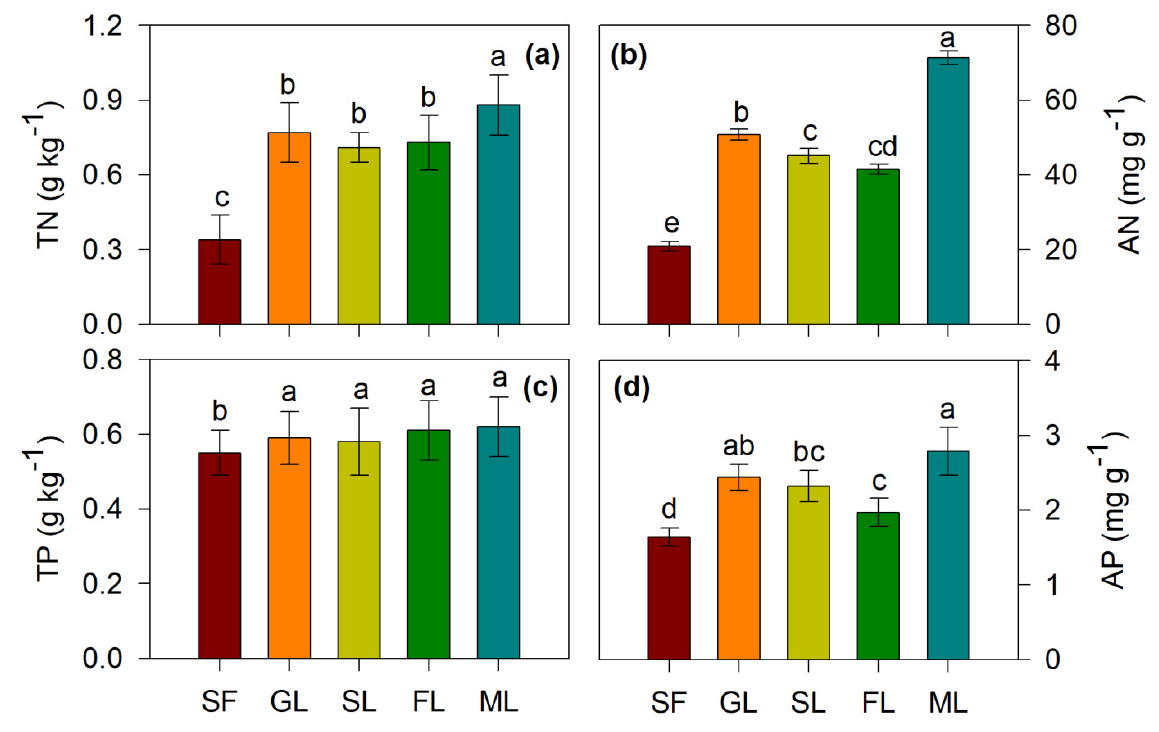
Figure 3. Soil N and P nutrients in different vegetation restoration types. TN ( a ), total nitrogen; AN ( b ), available nitrogen; TP ( c ), total phosphorus; AP ( d ), available phosphorus. Note: SF, Sloping farmland; GL, Grassland; SL, shrubland of Caragana korshinskii ; FL, forestlands of Robinia pseudoacacia ; ML, mixed forests of Robinia pseudoacacia + Caragana korshinski . Different lower-case letters above the error bars indicate significant differences in different land use types at 0.05 level ( p < 0.05). Data are Means ± SE. n = 3. Table 2. Soil enzymes activities in different vegetation restoration types. Note: SF, Sloping farmland; GL, Grassland; SL, shrubland of Caragana korshinskii ; FL, forestlands of Robinia pseudoacacia ;; ML, mixed forests of Robinia pseudoacacia + Caragana korshinski . Different lower-case letters mean significant differences in different land use types at 0.01 level ( p < 0.01). Data are Means ± SE. n = 3.